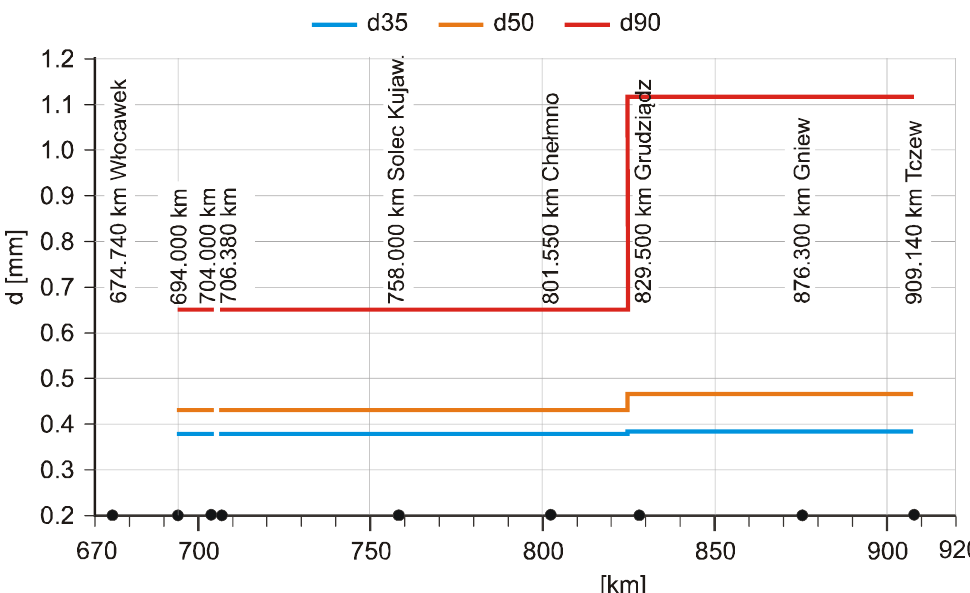
Figure 7. The changes of the characteristic grain diameters of bottom material along the Vistula River assumed for the simulations.